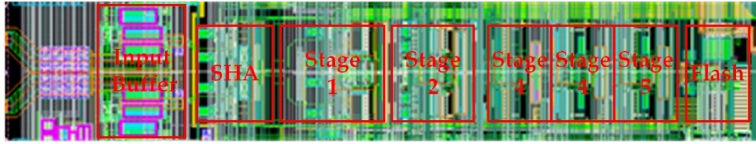
Figure 13. Vres of MDAC1 before and after calibration. Blue line is the ideal Vres, red line is the measured Vres. ( a ) Vres of MDAC1 before calibration; ( b ) Vres of MDAC1 after calibration.